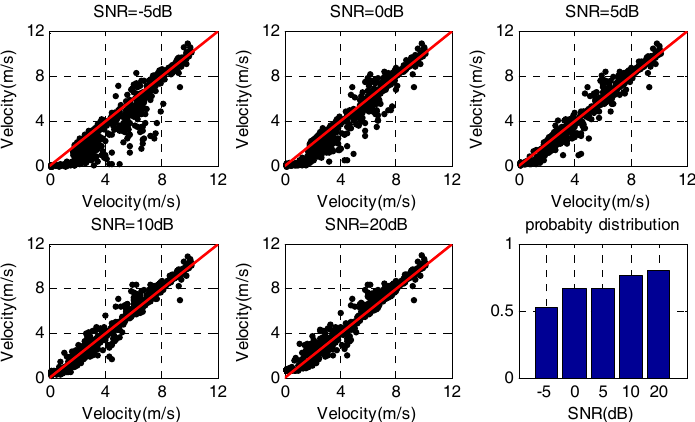
Figure 10. Velocity estimation bias and probability distribution of FDPP at different SNR. The red line in the scatter plots represents the zero-deviation standard, and the histogram indicates the probability of velocity bias being less than 0.5 m/s.